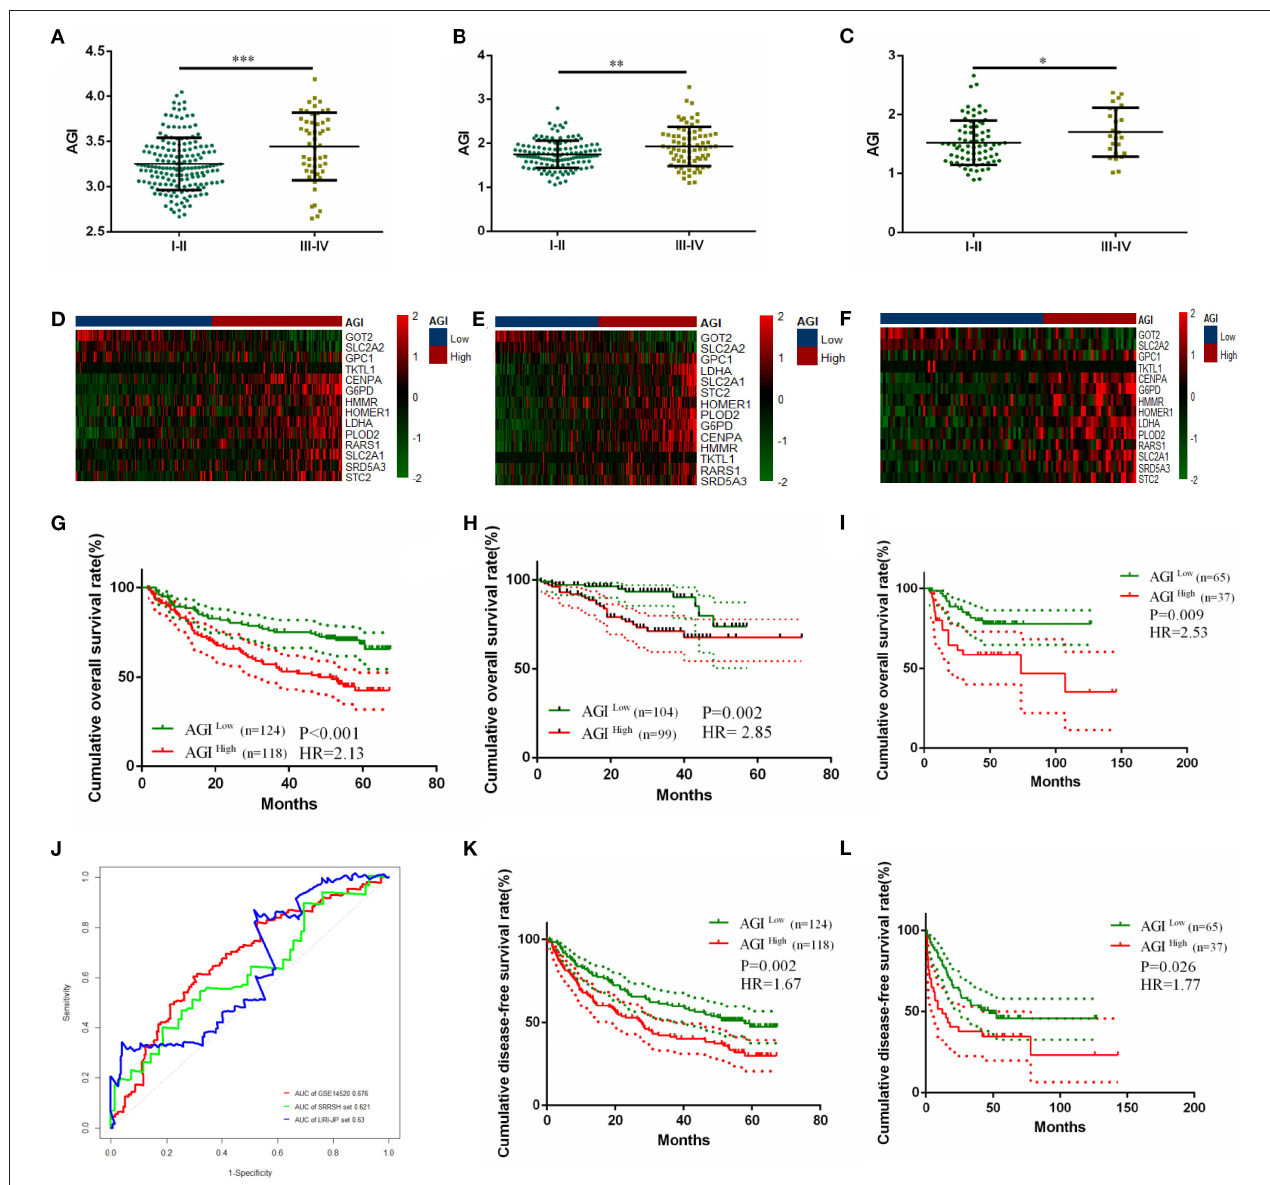
FIGURE 5 | Validating the prognostically predictive value of the aerobic glycolysis index (AGI) in validation datasets. (A–C) Value of the AGI in different tumor stages in GSE14520 (A) , LIRI-JP (B) , and SRRSH set (C) . (D–F) The heatmap and distribution of the 14 AGI-related gene expression profiles in GSE14520 (D) , LIRI-JP (E) , and SRRSH set (F) . (G–I) Kaplan–Meier plot analysis of overall survival (OS) in the high and low AGI subgroups in GSE14520 (G) , LIRI-JP (H) , and SRRSH set (I) . (J) Time-dependent ROC analysis comparing the predictive value of the AGI for 5-year OS in the three datasets. (K,L) Kaplan–Meier plot analysis of disease-free survival (DFS) in the high and low AGI subgroups in GSE14520 (K) and SRRSH set (L) . * P < 0.05, ** P < 0.01, *** P < 0.001.